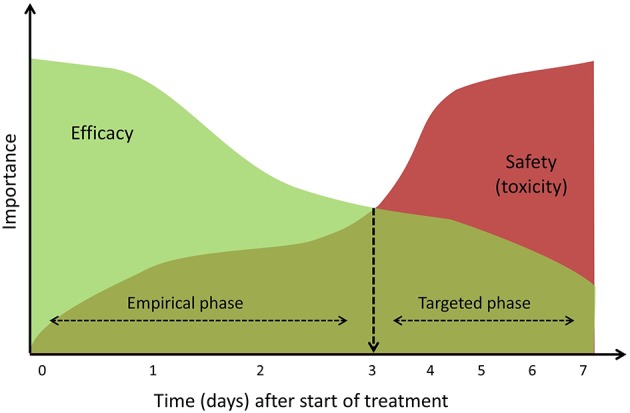
Conceptual visualization of impact of efficacy and toxicity during antibiotic treatment. During the empirical phase, focus lies on an efficacious treatment and when sepsis is confirmed (~3 days) treatment can be individualized and focus should shift to the safety of treatment.